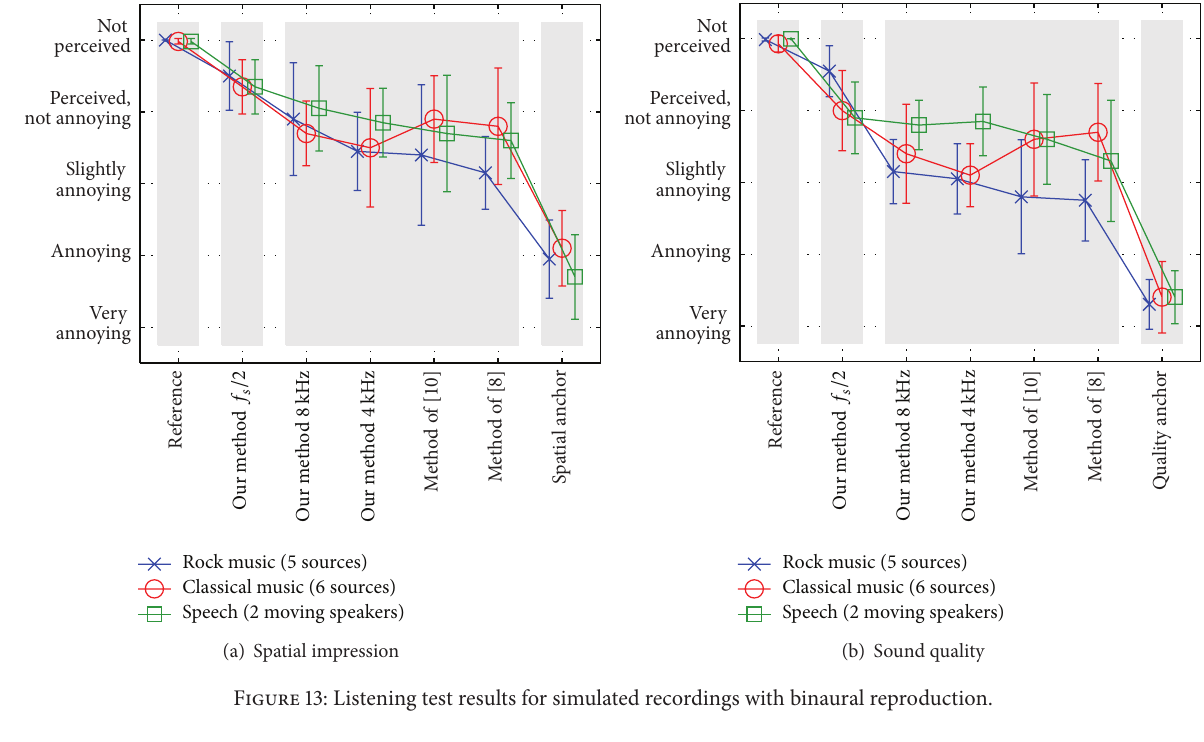
Figure 13: Listening test results for simulated recordings with binaural reproduction.